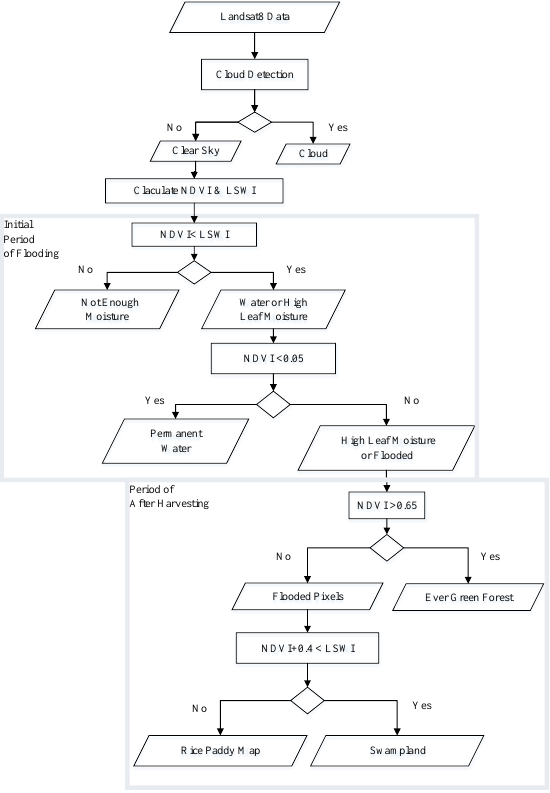
Figure 2. Schematic algorithm steps 2.2.1 Cloud masking: In paddy detection process, clouds existence even in sub pixels can cause uncertainties (Xiao et al., 2006 ). Therefore all of the clouds should be excluded from further analysis. In this research bands red (0.66 μm), NIR (0.870 μm), and blue (0.470 μm) are used to gain proper cloud mask. Owing to the higher reflectance of clouds, bands red and Figure 1. Landsat 8 RGB image of Gilan province in Iran, as research NIR more than 0.2 and band blue more than 0.25 was used to case study. mask cloud